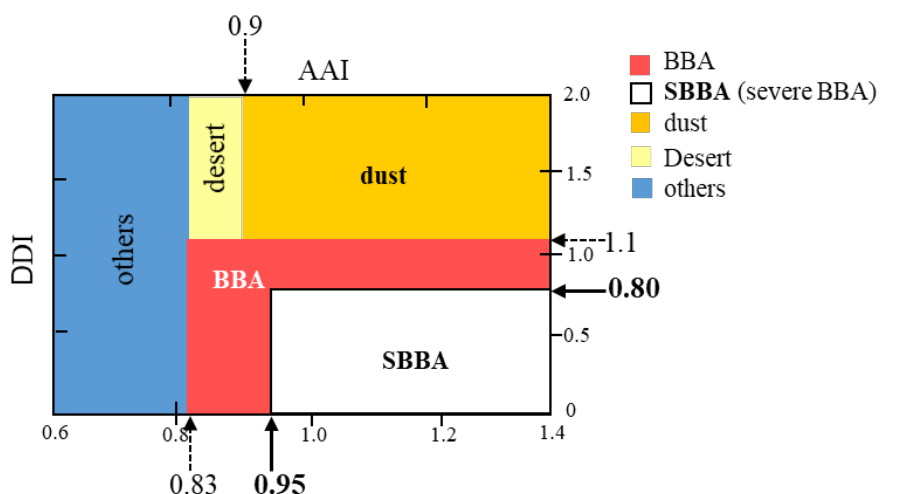
Figure 1. Continental aerosol type classification chart. Horizontal and vertical axes denote AAI and DDI values, respectively. Aerosol type category is shown in the upper right key. Some data was obtained from a previous study [22].